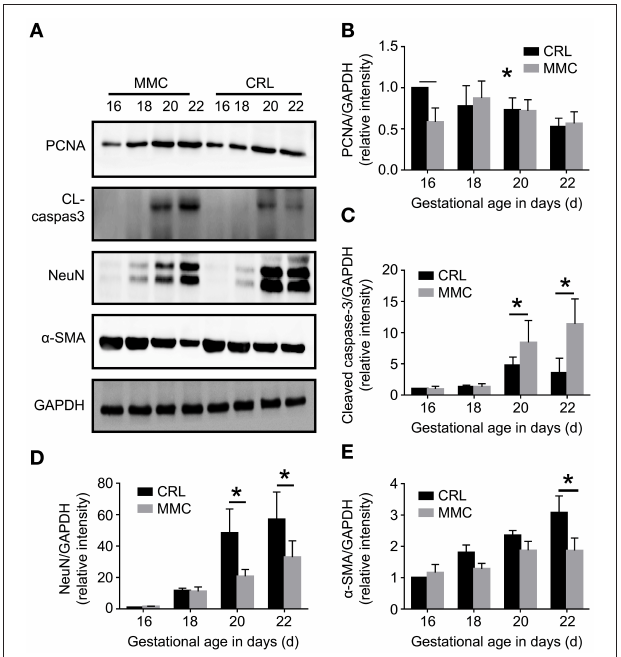
FIGURE 3 | Expression and distribution of bladder cleaved caspase-3 at E22. (A) The distribution of cleaved caspase-3 at E22. (B) The expression of cleaved caspase-3 in the bladder muscle layer was significantly lower in the CRL group than in the MMC group. (C) The expression of cleaved caspase-3 in the bladder mucosa layer was significantly higher in the MMC group than in the CRL group, n = 6, * P < 0.05. Data are expressed as means ± STDs. MMC, myelomeningocele; STD, standard deviation; CRL,